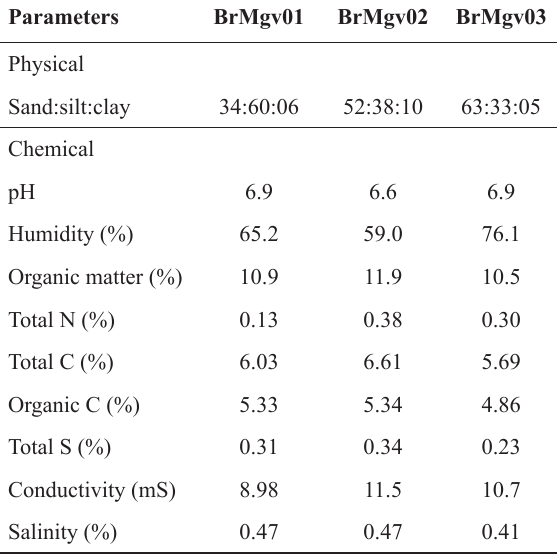
Physical and chemical characteristics of soil samples collected in the three mangrove areas (modified from Dias et al.